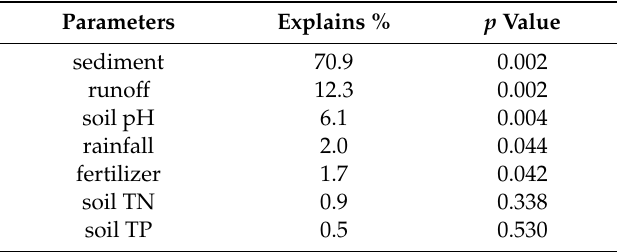
Figure 8. Redundancy analysis (RDA) analysis of environmental factors of nitrogen and phosphorus nutrient loss for different treatments. The nutrient loss was indicated in blue text, including total nitrogen (RTN), total dissolved nitrogen (RTDN), nitrate nitrogen (RNO 3 − -N), ammonium nitrogen (RNH 4+ -N), total phosphorus (RTP) and total dissolved phosphorus (TDP) in runoff and total nitrogen (SedTN), total phosphorus (SedTP) in sediment. Environmental factors indicated in red text included sediment, runoff, soil pH, rainfall, fertilizer, soil TN, and soil TP. Different treatments were four kinds of color circles. Subscript 1 to 4 of color circles represented 2014 to 2017. Table 3. Result of Monte Carlo permutation test for the test of environmental impact factors of nitrogen and phosphorus nutrient loss.